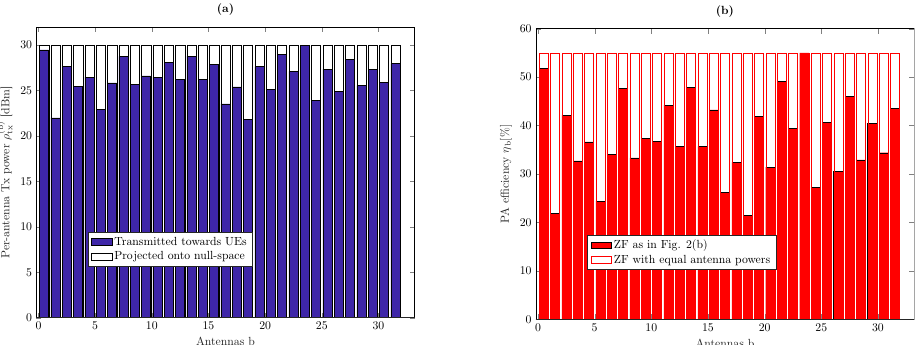
Figure 3. ( a ) Per-antenna transmit power values and ( b ) corresponding PA efficiencies for transmis- sion with equal antenna powers versus conventional ZF for the same realization of the geometric channel as in Figure